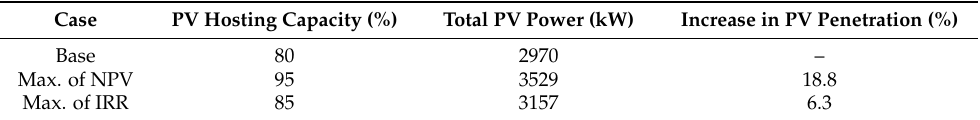
at node 32 in stochastic scenario I. node 32 in stochastic scenario